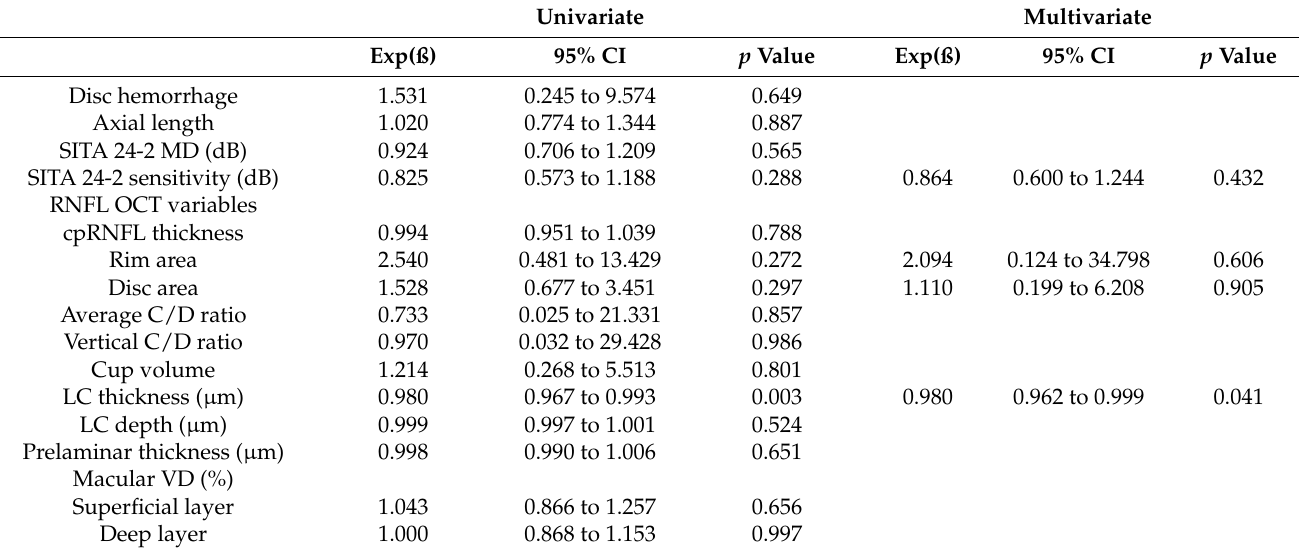
Table 4. Factors associated with deep VD defects from OCTA.